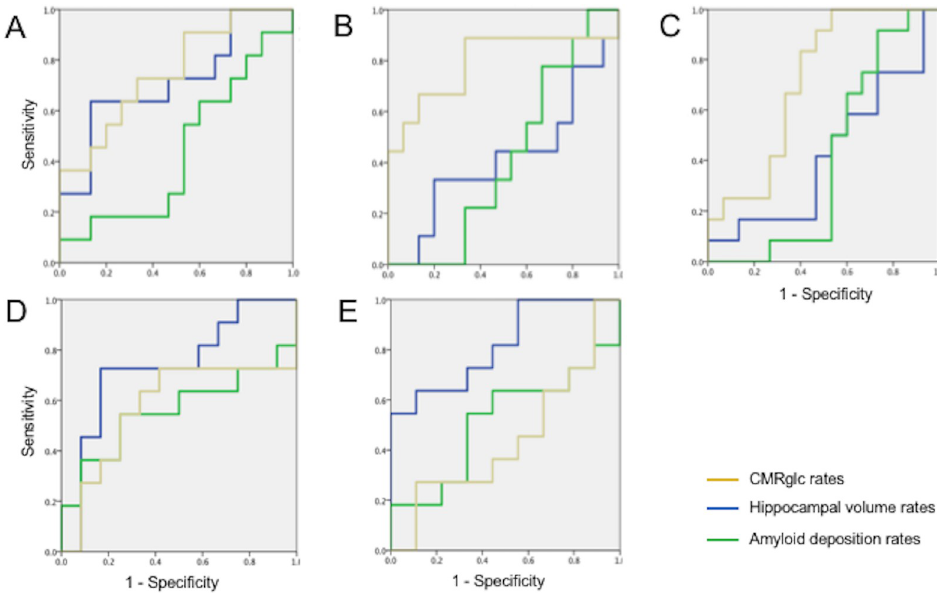
Fig 1. ROC curves showing group separation as predicted by AD biomarkers. A) MENO vs. males; B) PERI vs. males; C) PRE vs Men; D) MENO vs PERI; E) MENO vs PRE. Graphs show group separation as predicted by 3-year changes in FDG-PET CMRglc in frontal cortex (blue; age-adjusted measures), PiB-PET amyloid load in frontal cortex (orange; age-adjusted measures), and hippocampal volume (green; age and TIV-adjusted measures). MENO vs PRE . Hippocampal volume rates were the only predictors of MENO vs. PRE with 78% accuracy ( X 2 = 6.41, p = 0.011; RR = 5.00, 95% C.I. 1.30–19.3; Fig 1E ). (1)